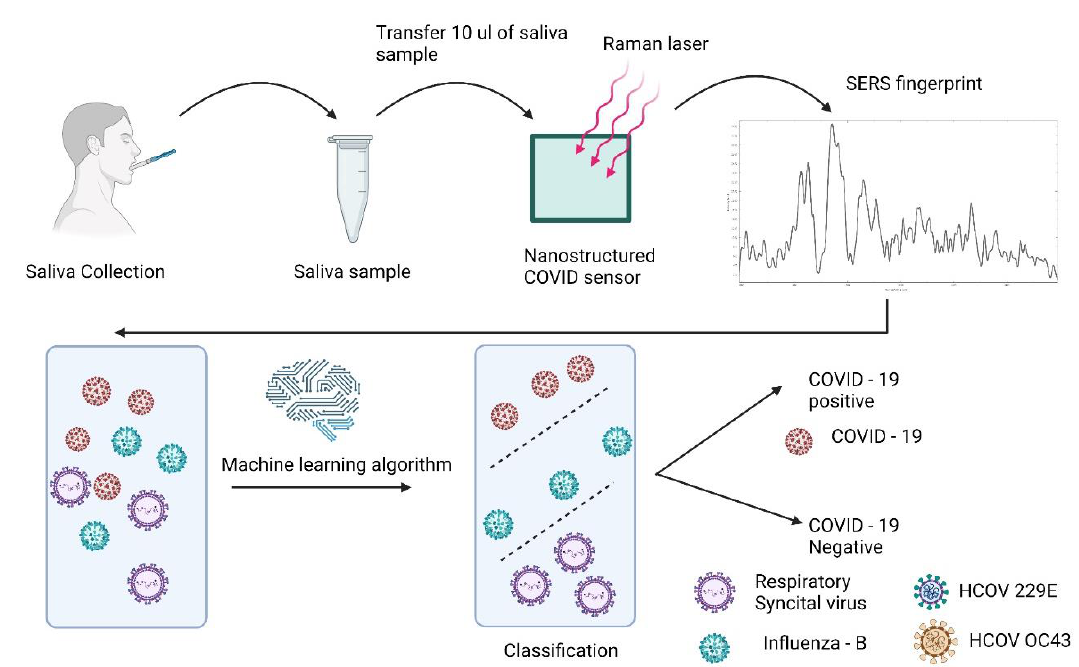
Figure 1. Schematic representation of the label-free rapid SARS-CoV 2 saliva test.